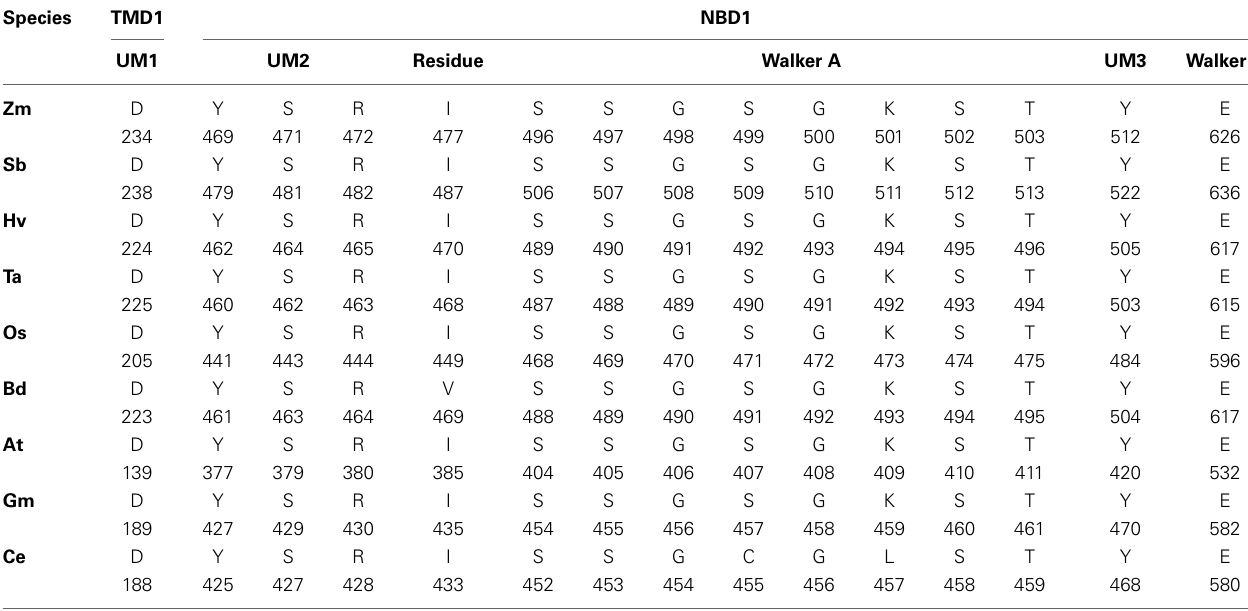
Table 1 | The predicted residues involved in ATP, ADP, and Mg binding in 3-D structures of ABCB1 in different species.